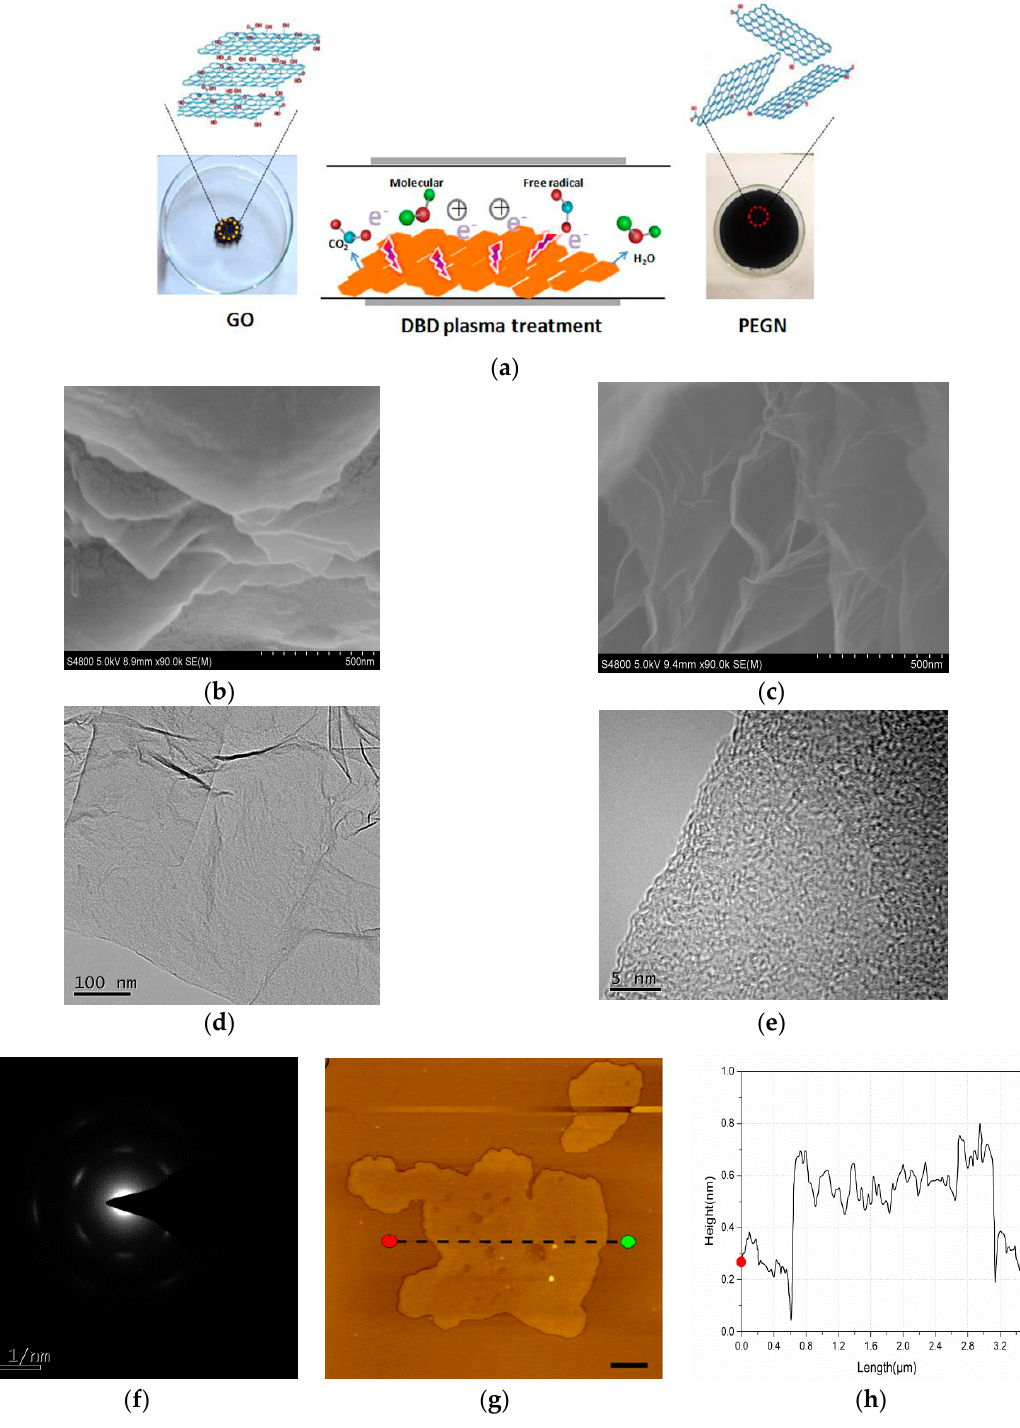
Figure 2. ( a ) Schematic representation of exfoliation and reduction of GO using DBD plasma technology; SEM images of ( b ) GO and ( c ) plasma-exfoliated graphene (PEGN); ( d ) TEM and ( e ) HRTEM images of PEGN; ( f ) selected area electron diffraction (SAED) pattern indicating a disruption of long-range ordering in graphene; ( g ) atomic force microscopy (AFM) images of PEGN (scale bar = 500 nm). ( h ) Height profiles along line in ( f ).